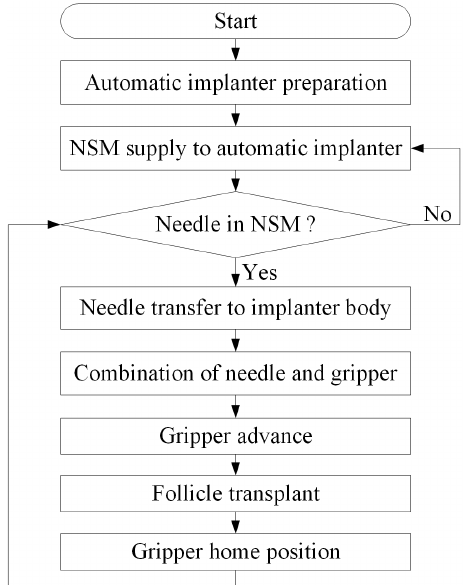
Figure 7. Operation flowchart for continuous needle supply and follicle transplantation. NSM: needle supply magazine.